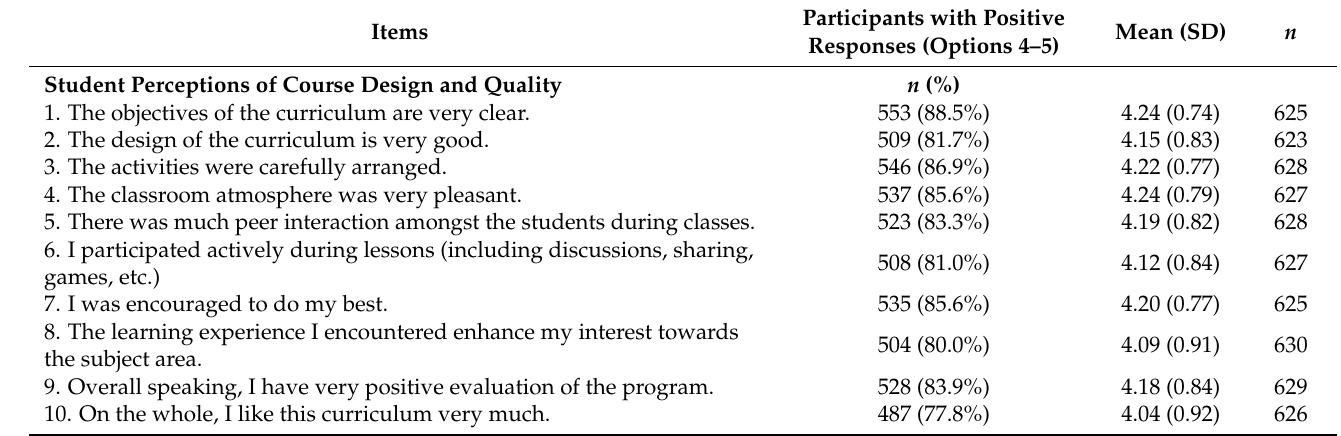
Table 3. Descriptive statistics and frequencies of positive responses in subjective outcome